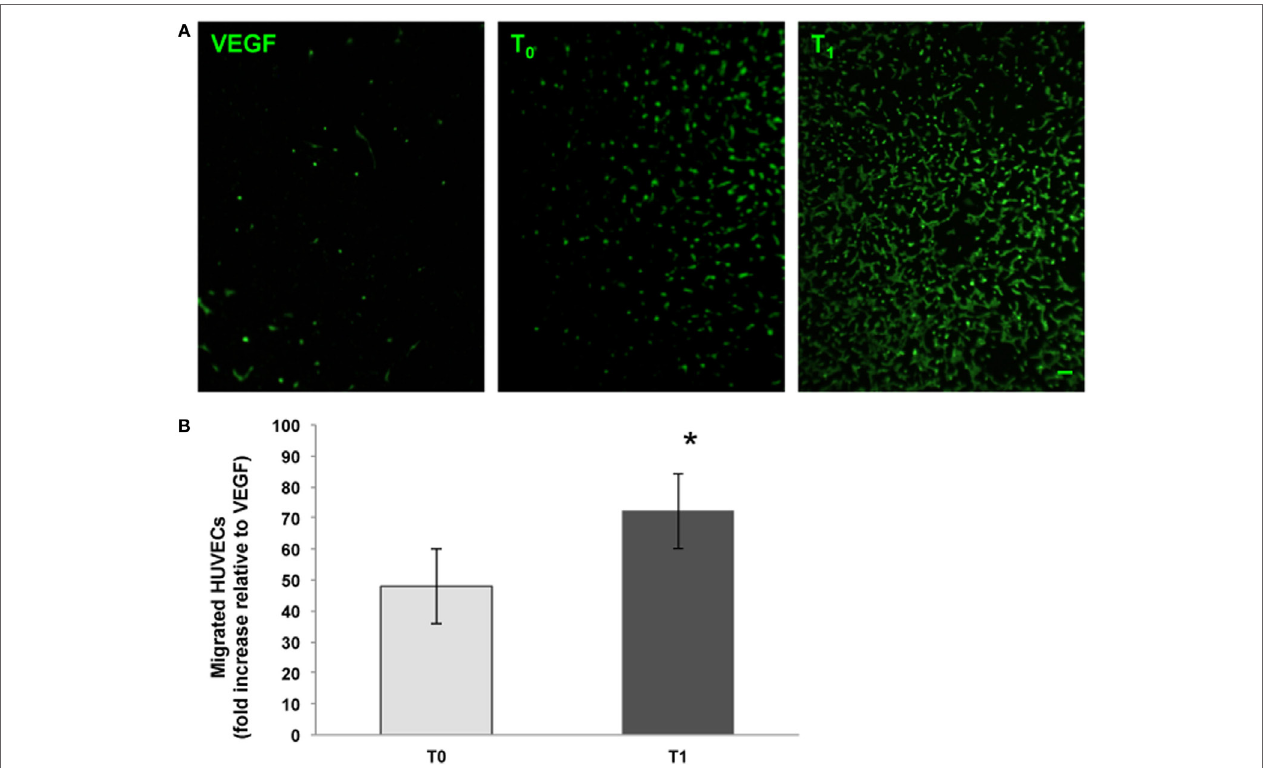
FigUre 2 | Endothelial cell migration assays . The chemoattractive potential of serum obtained from menopausal women before ( T 0 ) and after ( T 1 ) training was assessed. Vascular endothelial growth factor (VEGF) (10 ng/ml) was used as procedure control. Human umbilical vein endothelial cells (HUVECs) that had migrated were stained with the vital dye calcein AM (green fluorescence). Original magnification: 20 × . Bar scale: 10 µm. The graph shows the number of migrated cells expressed as the fold increase relative to the control. *Significantly different from T 0 ( t = − 10.84, P < 0.001).